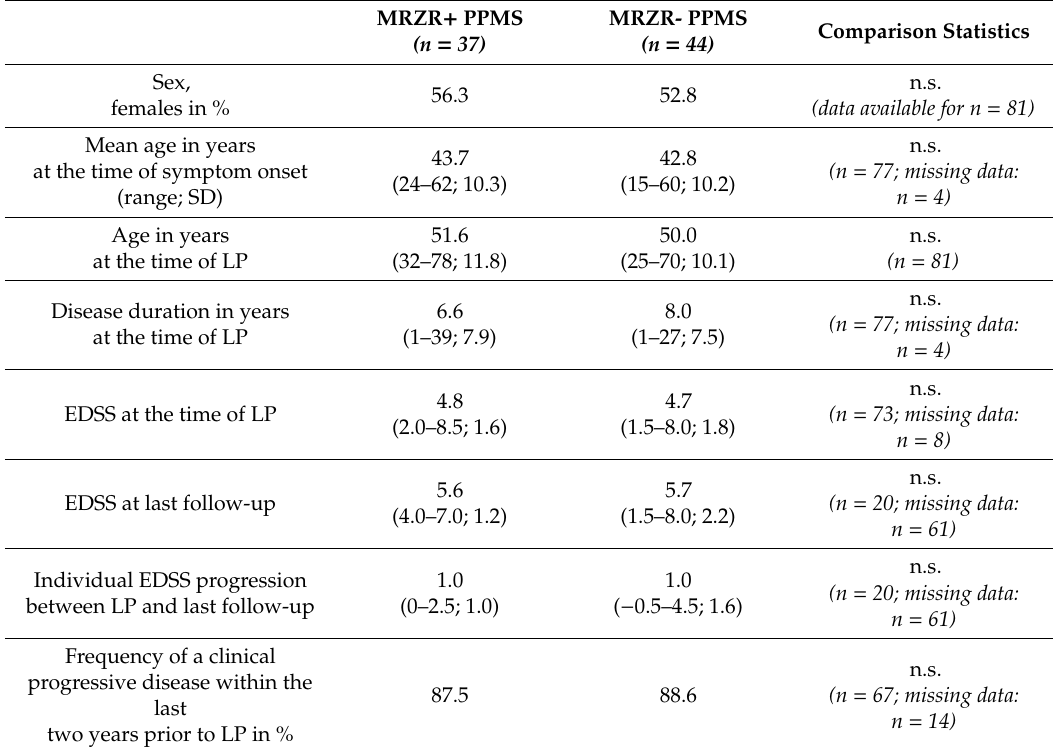
Table 1. Clinical